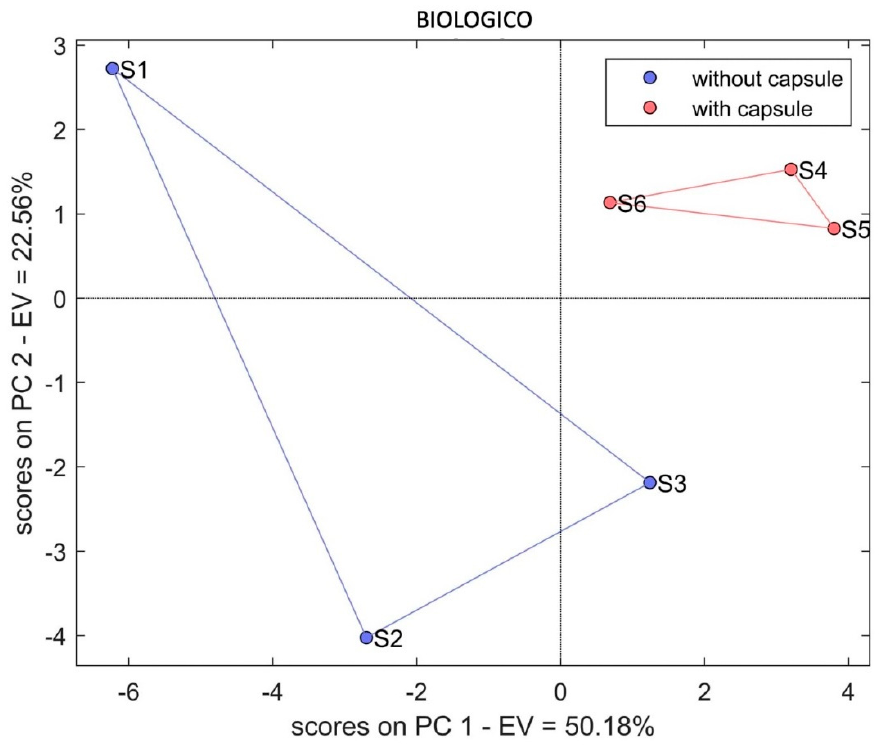
Figure 5. PCA score showing the comparison between volatile spectra compound of Biologico coffee “with capsule” and “without capsule” exhibiting an EV (explained variance) = 72.74%.